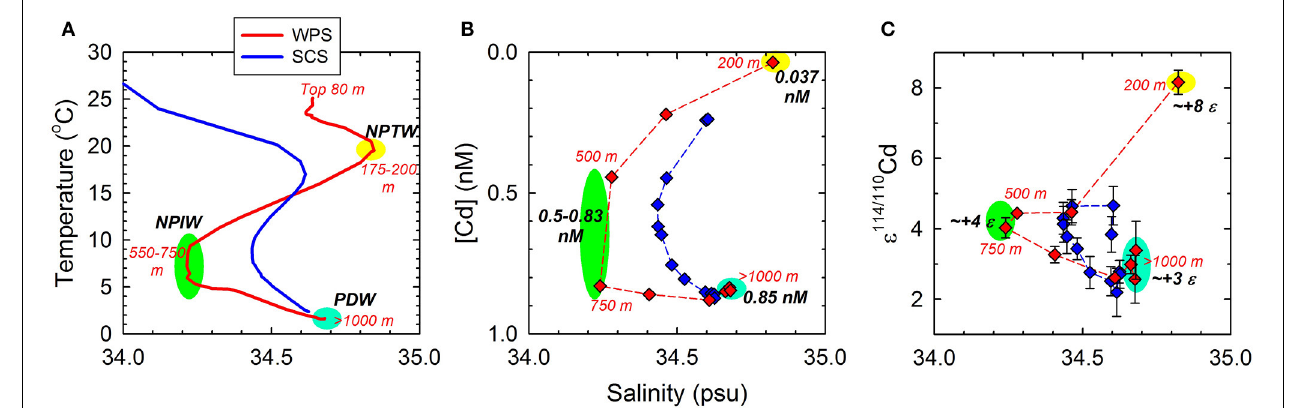
water column profile, and Figures 4B,C display the data in the thermocline and deep waters. The data of SCS is quoted from Yang et al. (2012).